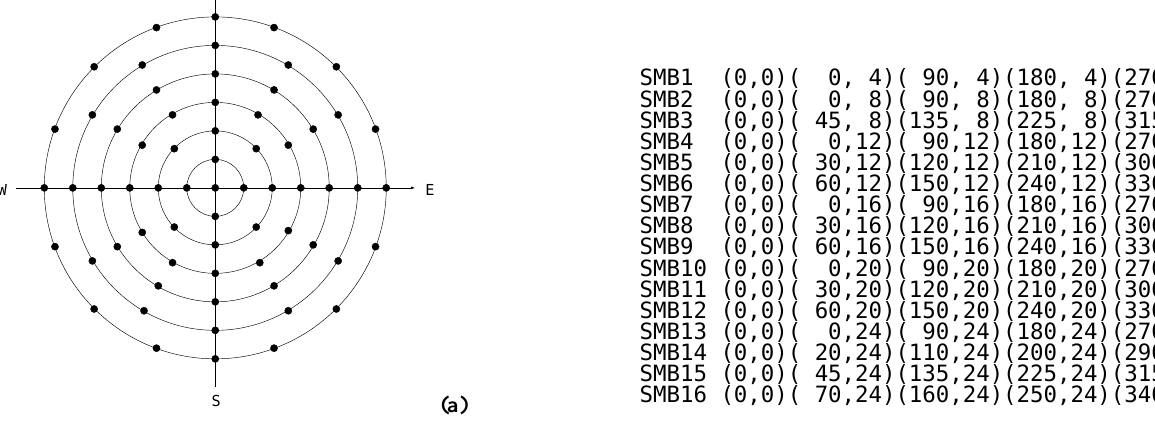
Fig. 1. Layout of the 65 radar beams of the SMB experiment (left) and a table showing the azimuth and zenith directions of the each DBS set